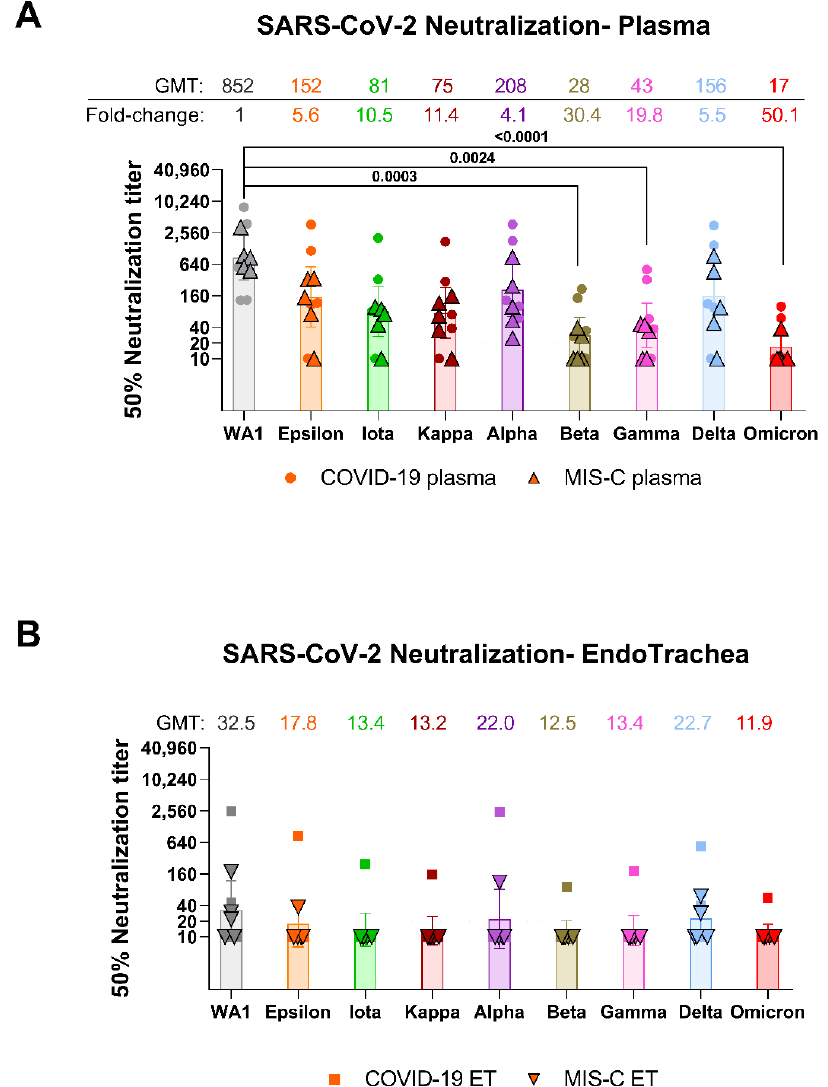
Figure 1. Neutralizing antibody responses in plasma and endotracheal aspirates of pediatric COVID-19 and MIS-C against SARS-CoV-2 WA1/2020 strain and variant strains. SARS-CoV-2 neutralizing antibody titers of plasma ( A ) and endotracheal aspirates ( B ) from 5 COVID-19 and 5 MIS-C pediatric patients against SARS-CoV-2 WA1/2020 strain, VOIs; Epsilon, Iota, Kappa, and VOCs; Alpha, Beta, Gamma, Delta and Omicron variant by pseudovirion neutralization assay (PsVNA). The assay of each sample was performed in duplicate to determine the 50% neutralization titer (PsVNA50). Each data point represents an individual sample (circles) and indicates the 50% neutralization titer obtained with each sample against the indicated pseudovirus. Individual COVID-19 plasma samples are shown as circles, while MIS-C plasma samples are shown as triangles in panel A. In panel B, the endotracheal aspirates samples from pediatric COVID-19 are shown as squares, while MIS-C are shown as inverted triangles. The heights of the bars and the numbers over the bars indicate the geometric mean titers, and the whiskers indicate 95% confidence intervals. The horizontal dashed line indicates the limit of detection for the neutralization assay (PsVNA50 of 20). The fold-change indicates the average decrease in neutralization titer of the indicated variants as compared with that of the SARS-CoV-2 WA1/2020 virus. The raw data and information regarding the samples for each pediatric participant (age and 50% neutralization titers against various SARS-CoV-2 strains) are summarized in Supplementary Table S1. Differences in neutralization titers between SARS-CoV-2 strains were analyzed by lme4 and emmeans packages in R using Tukey’s pairwise multiple comparison test and the p -values are